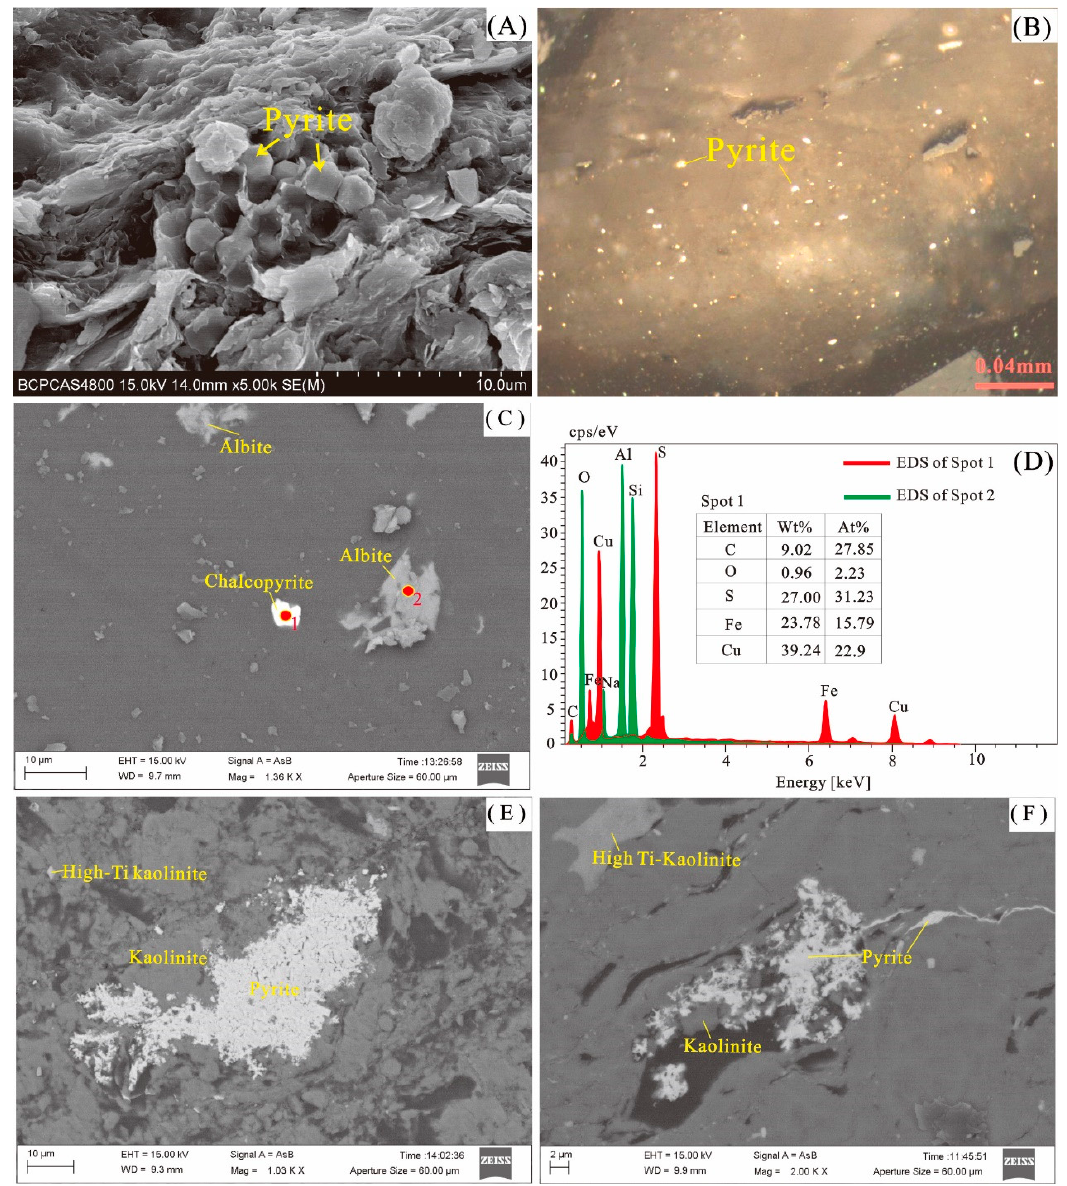
Figure 7. Characteristics of the mineral phases in the samples from Dongpo Mine. ( A ) Discrete pyrite particles in sample DP5 -2 -5, SEM under “SE mode”. ( B ) Disseminated pyrite in the veined calcite in sample DP5 -2 -5, Reflected light, oil immersion. ( C ) Chalcopyrite and albite in sample DP5 -2 -2, SEM under “BSE mode”. ( D ) EDS spectrum of Spots 1 and 2. ( E ) Massive pyrite and kaolinite in sample DP5 -2 -7-p, SEM under “BSE mode”. ( F ) Fracture-filling pyrite and kaolinite in sample DP5 -2 -3-p, SEM under “BSE mode”.